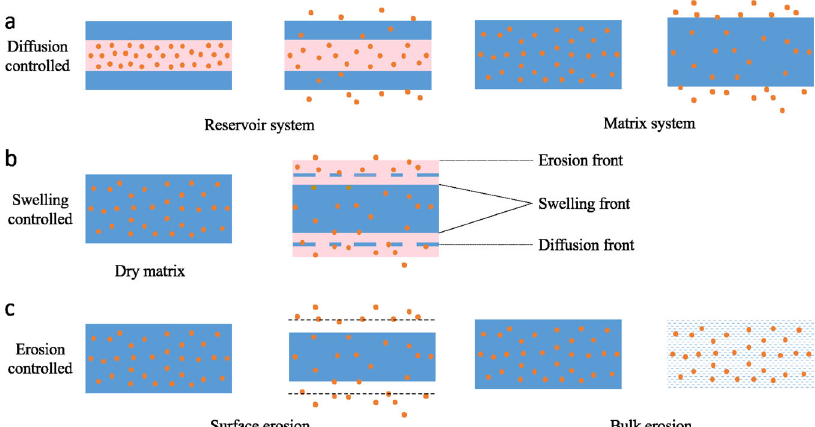
Fig. 5 Three common release mechanisms utilized in active packaging. a Diffusion-controlled release. b Swelling-controlled release. c Erosion-controlled release.